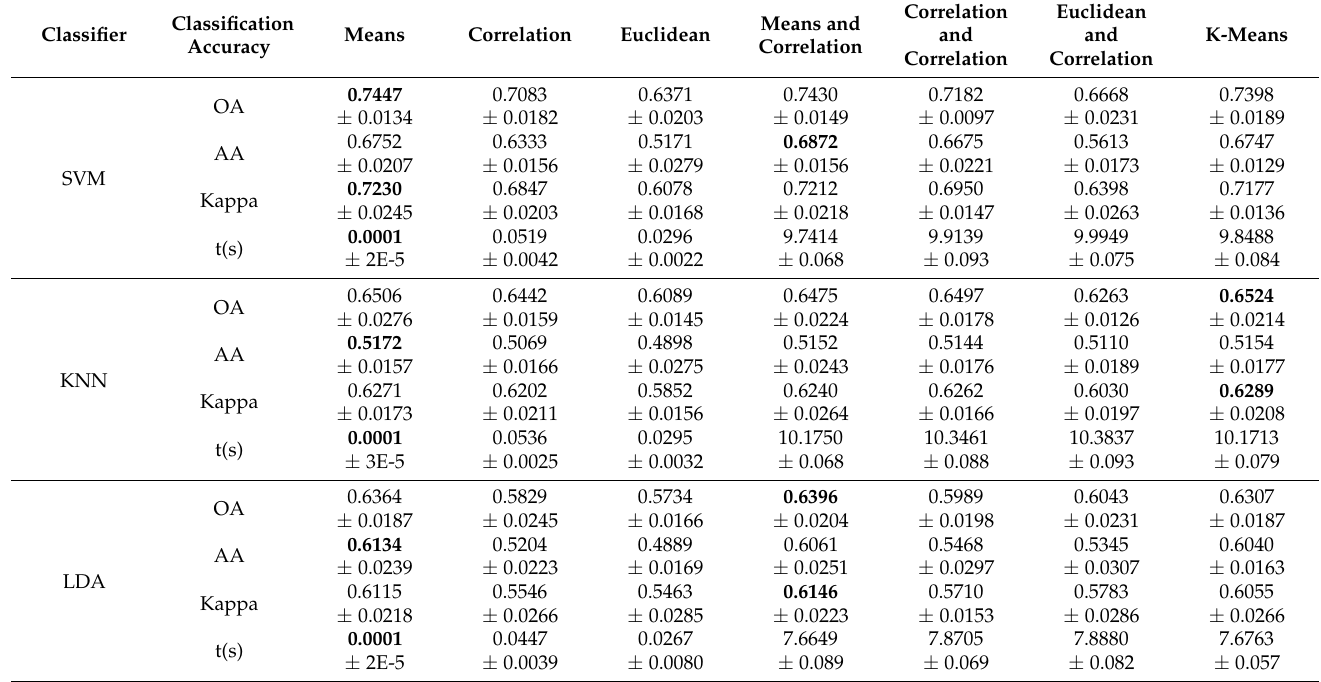
Table 1. Comparison of Different Subspace Partitioning methods on Indian Pines Data